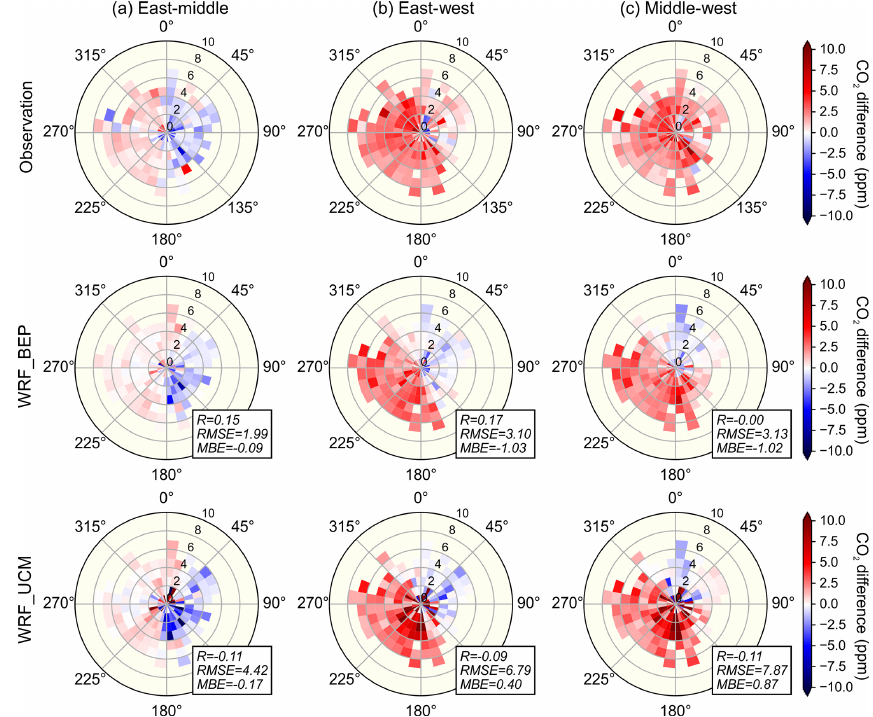
Figure 7. Spatial differences in CO 2 concentration between (a) east–middle, (b) east–west, and (c) middle–west parts of the GreenLITE ™ T1 measurement, averaged accounting for wind speed and direction. Only the afternoon (11:00–16:00UTC) data are used. The top row shows the observations, whereas the other two rows show the two simulations (UCM, BEP). The statistics of hourly values of observed and modeled CO 2 concentration difference are shown in the